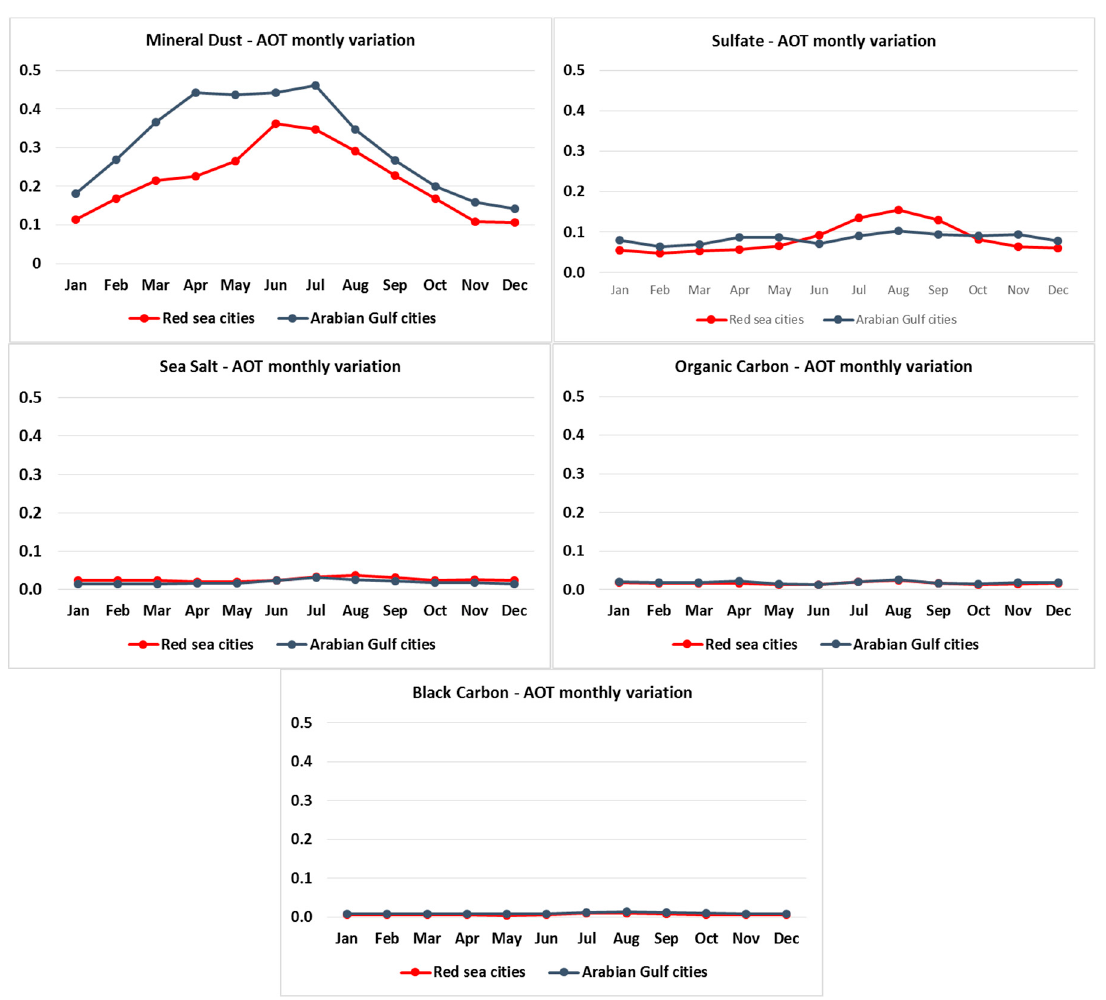
Figure 8. Monthly variation in aerosol AOT over the Arabian Peninsula cities—cities on the Red Sea vs. cities on the Arabian